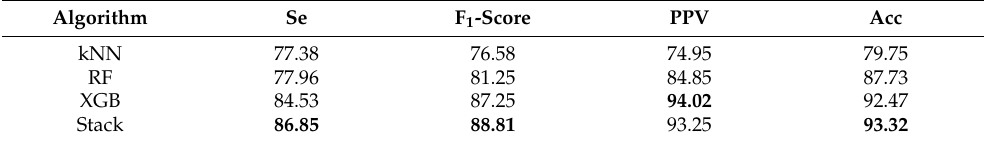
Table 5. Average classification performance of the classifiers for all subjects for S = 6 s with O = 3 s. The numbers are in percentage and the highest performances of the different models are given in bold.